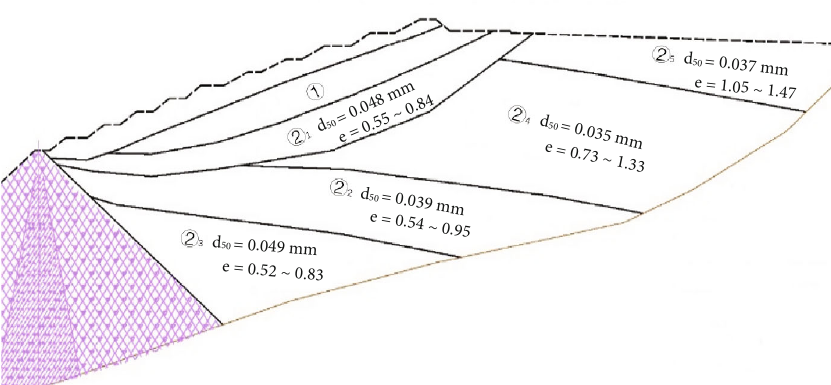
Figure 8: Geological pro fi le of the tailing